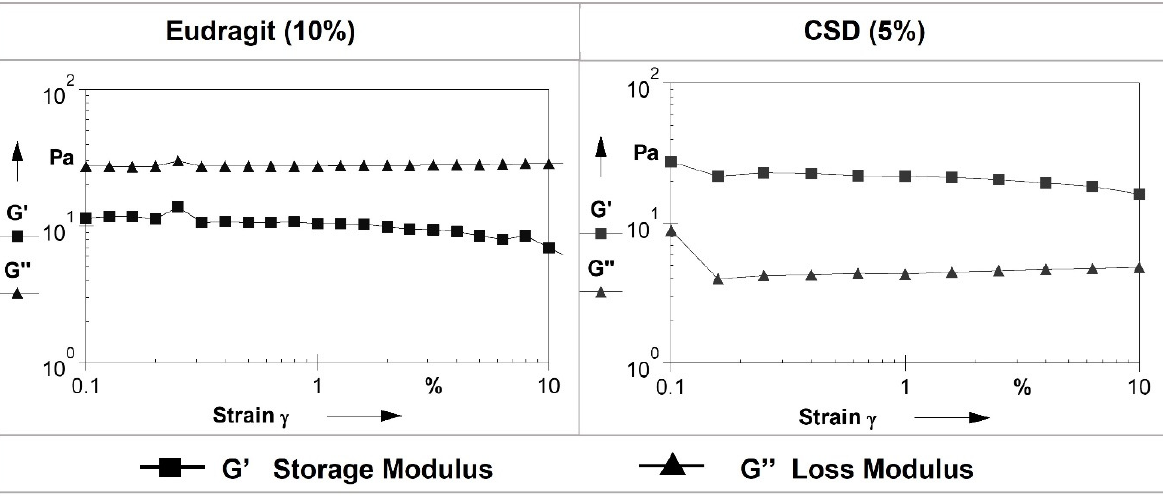
Figure 5. Rheological characterizations of gels: amplitude sweep tests of Eudragit (10%) and CSD (5%) gels.